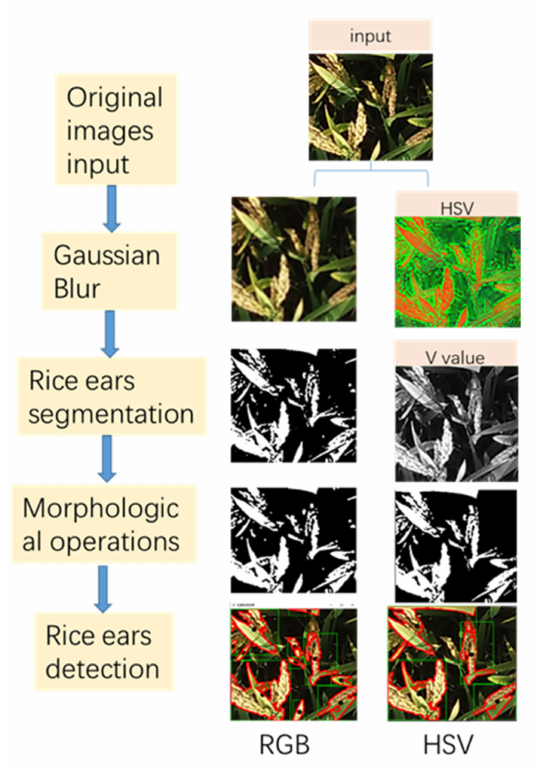
Figure 3. The rice ear segmentation processing flow in RGB and HSV color